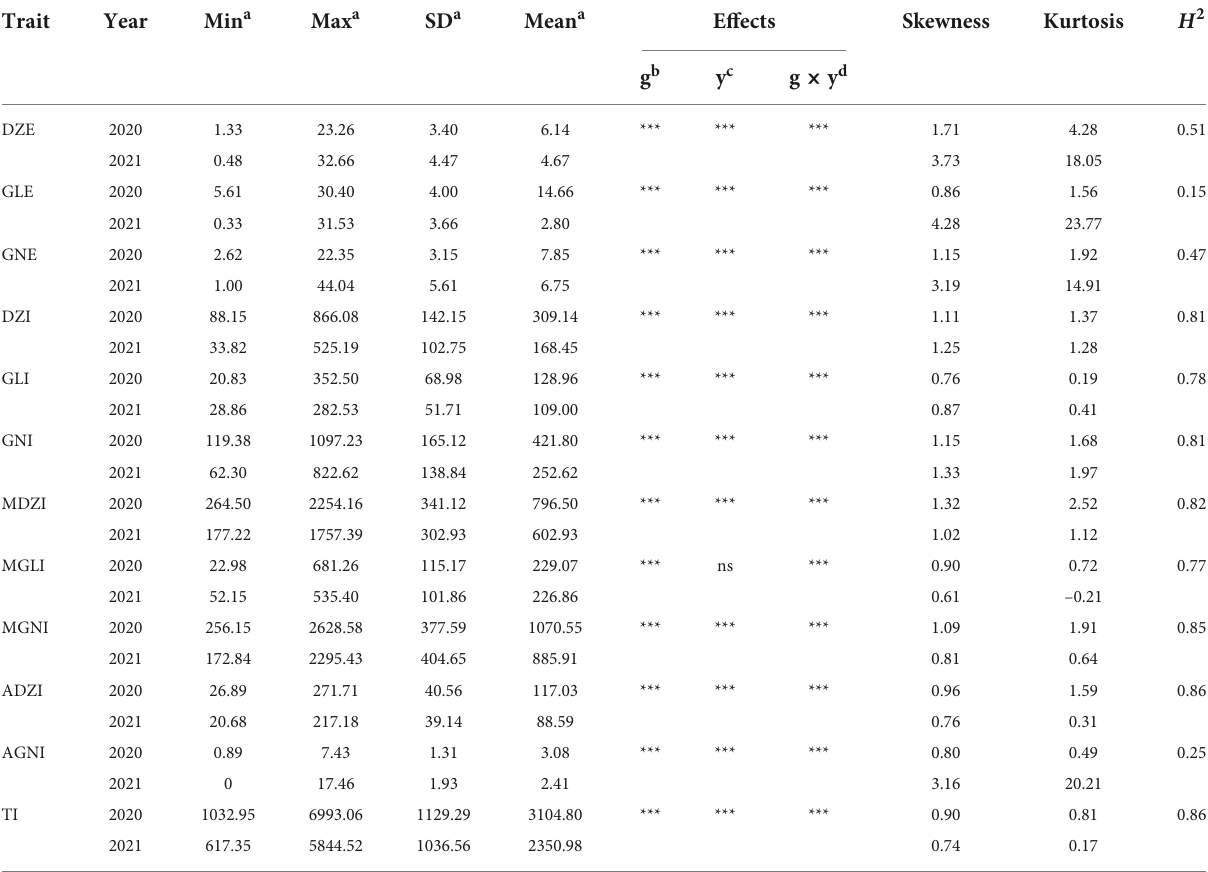
TABLE 1 Descriptive statistics, ANOVA analysis, and broad-sense heritability of isoflavone contents in MDP.